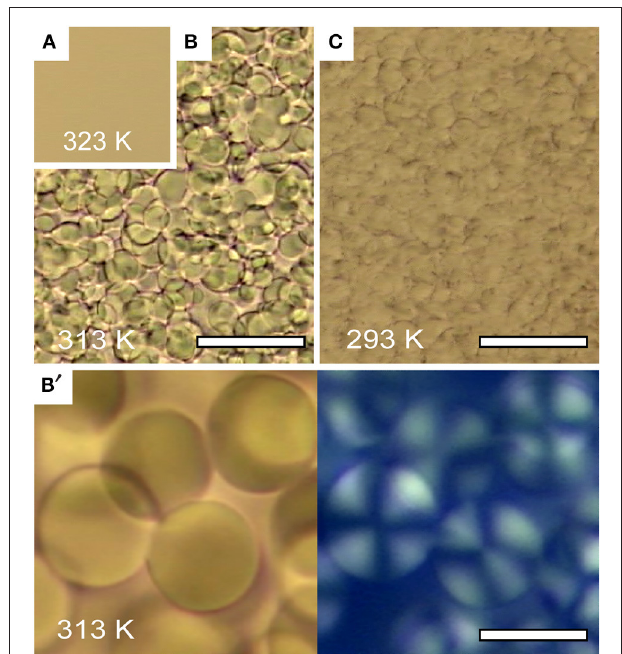
FIGURE 3 | Optical microscopy images of D 2 O/3MP/NaBPh 4 mixture at φ 3MP = 0.09 and C salt = 85 mmol/L φ 3MP = 0.09: (A) T = 323 K (disordered phase), (B) T = 313 K (lamellar phase), and (C) T = 293 K (lamellar phase). Scale bars in (B,C) indicate 100 µ m. (B ′ ) Magnified view of (B) (left) and a birefringent image of the same region (right) with the scale bar being 20 µ m. The figure is reproduced from Sadakane et al. [21] (Copyright 2009 by The American Physical Society). As per the copyright holder’s policies, no permission is required for the use of figures by the authors of the original